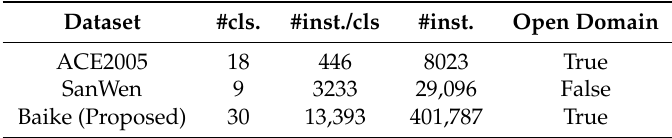
Table 2. Comparison of